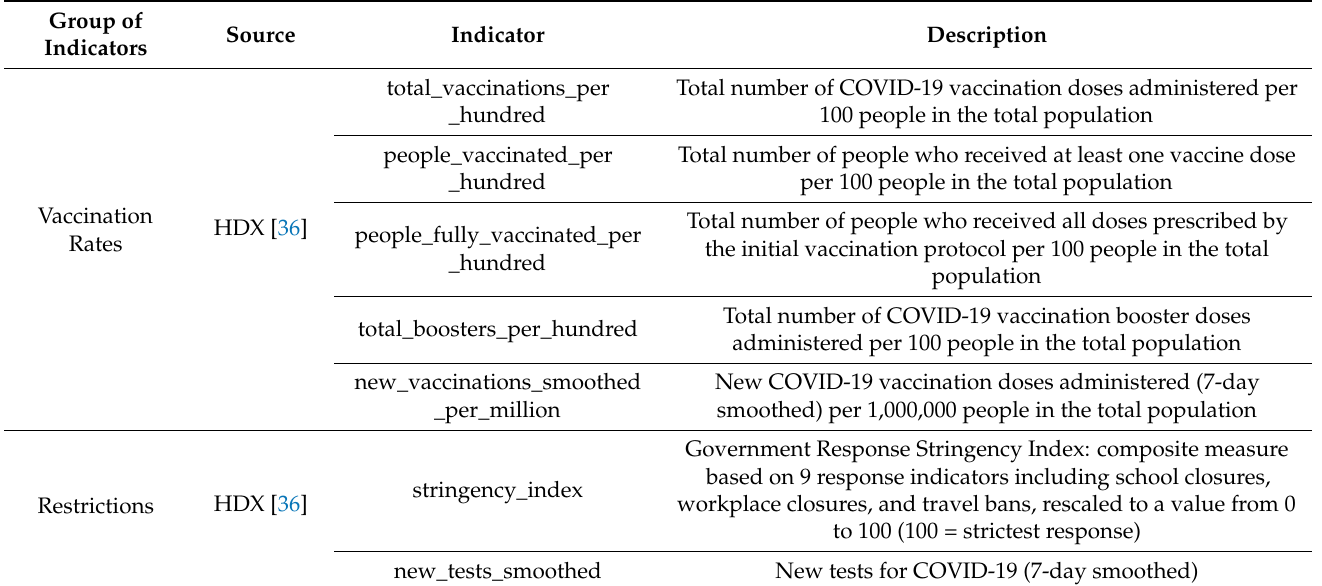
Table 1. Dataset with sources and indicator